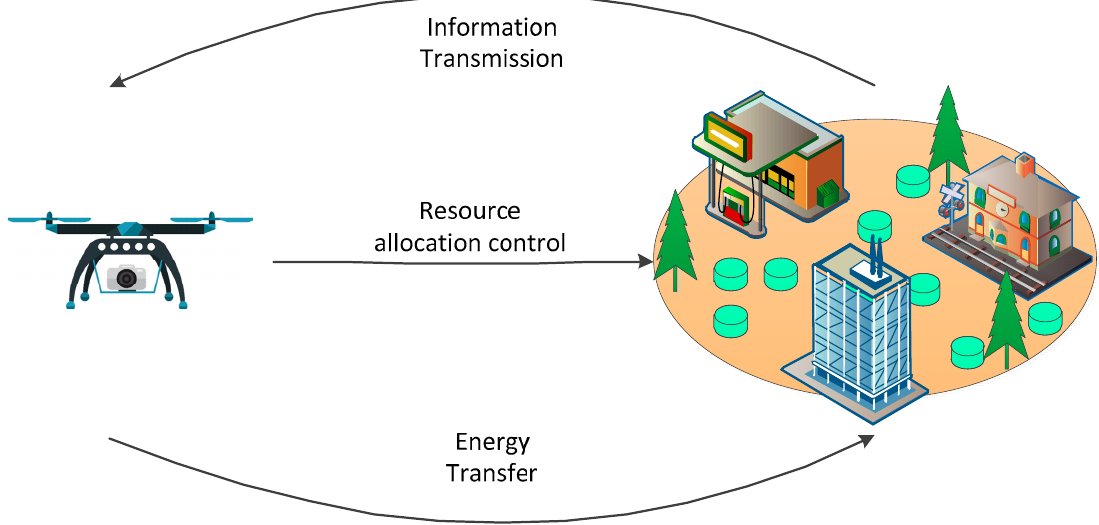
Figure 2. Leader-follower relationships between the UAV and the wireless nodes.